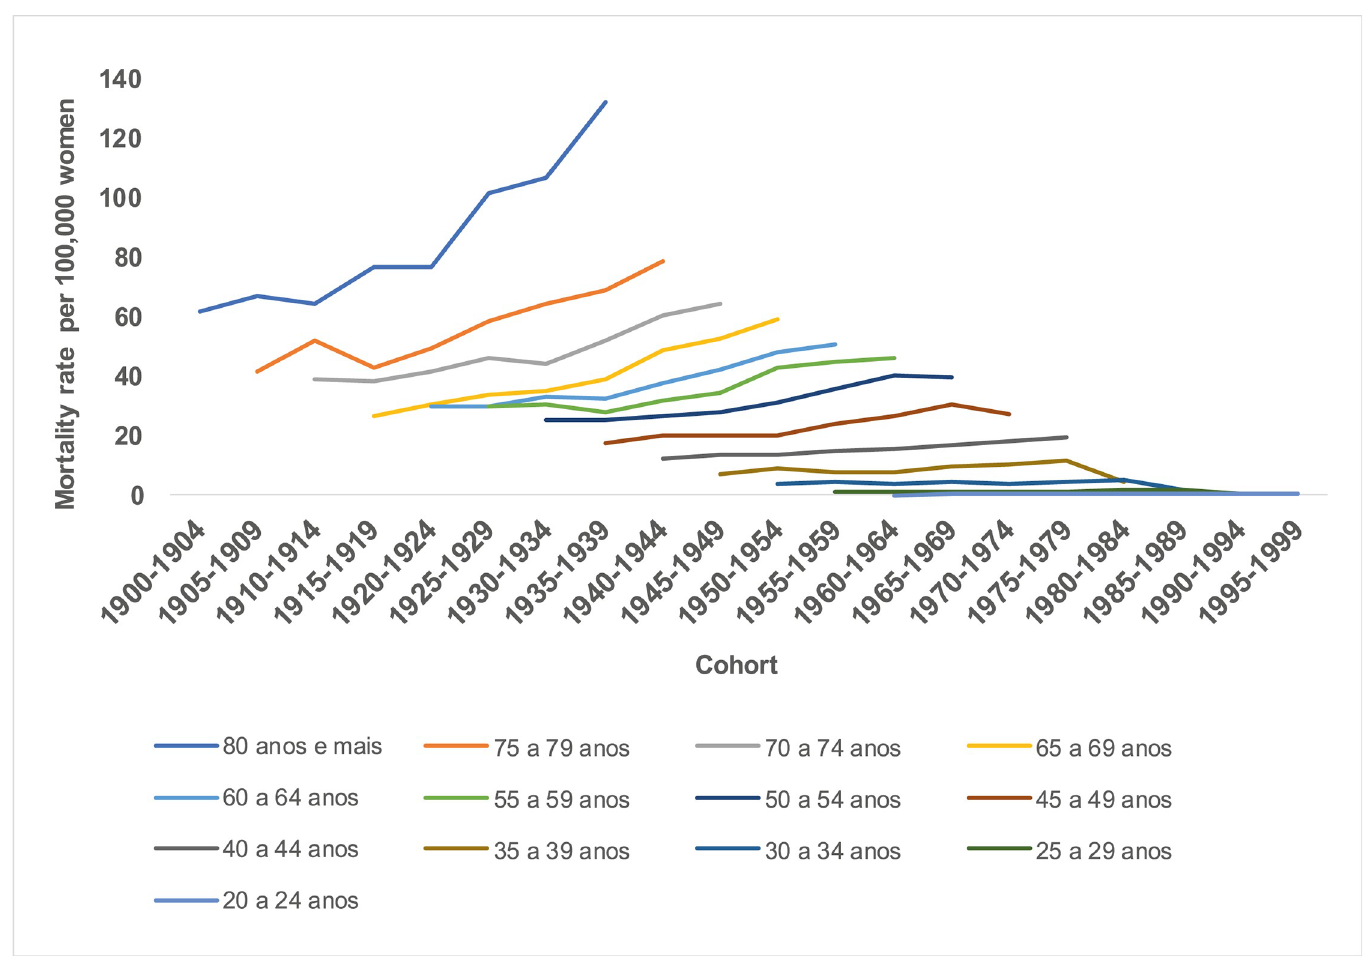
Fig 5. Breast cancer mortality rates by age group and death cohort in Northeast Brazil,